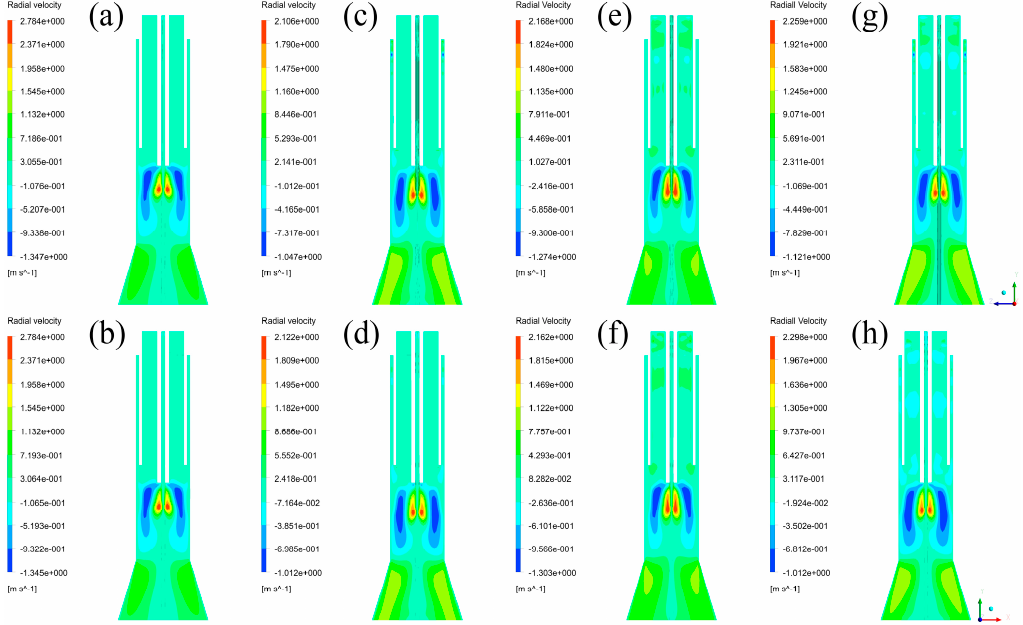
Figure 7. Radial velocity fields: ( a ) Case A in YZ plane, ( b ) Case A in XZ plane, ( c ) Case B in YZ plane, ( d ) Case B in XZ plane, ( e ) Case C in YZ plane, ( f ) Case C in XZ plane, ( g ) Case D in YZ plane, ( h ) Case D in XZ plane.